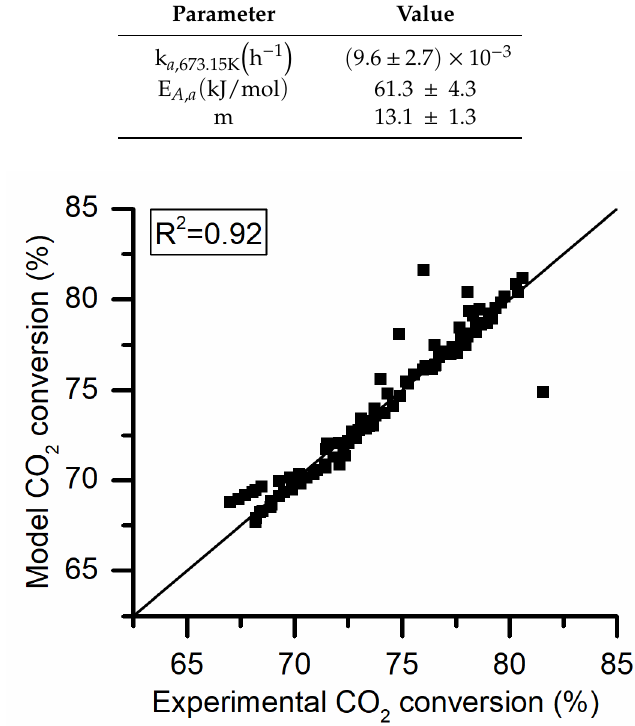
Figure 11. Parity plot for aging kinetics.